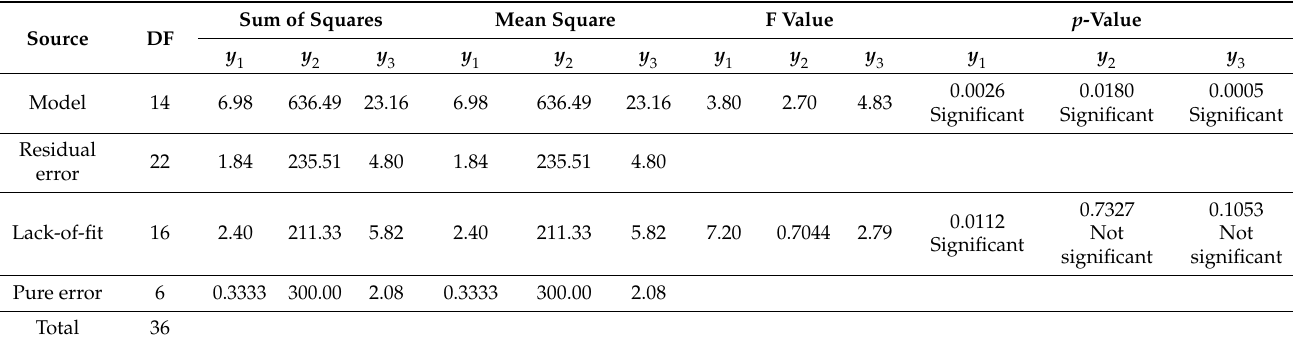
Table 1. Analysis of the variance (ANOVA) of the response surface quadratic model for pharmaceutically active compounds production from Streptomyces SUK